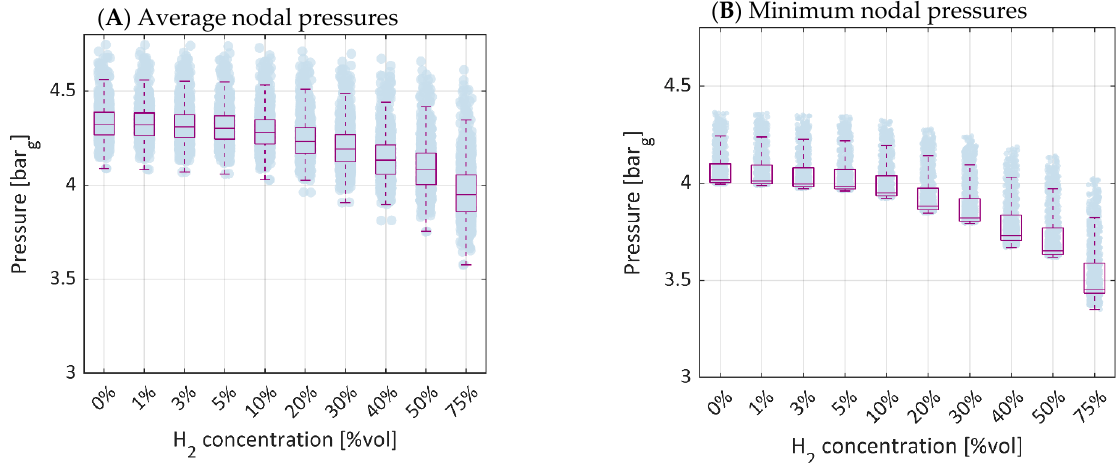
Figure 4. Evolution of average ( A ) and minimum ( B ) nodal pressures recorded in 1000 networks with increasing H 2 concentrations—H 2 –NG blend supplied from the city